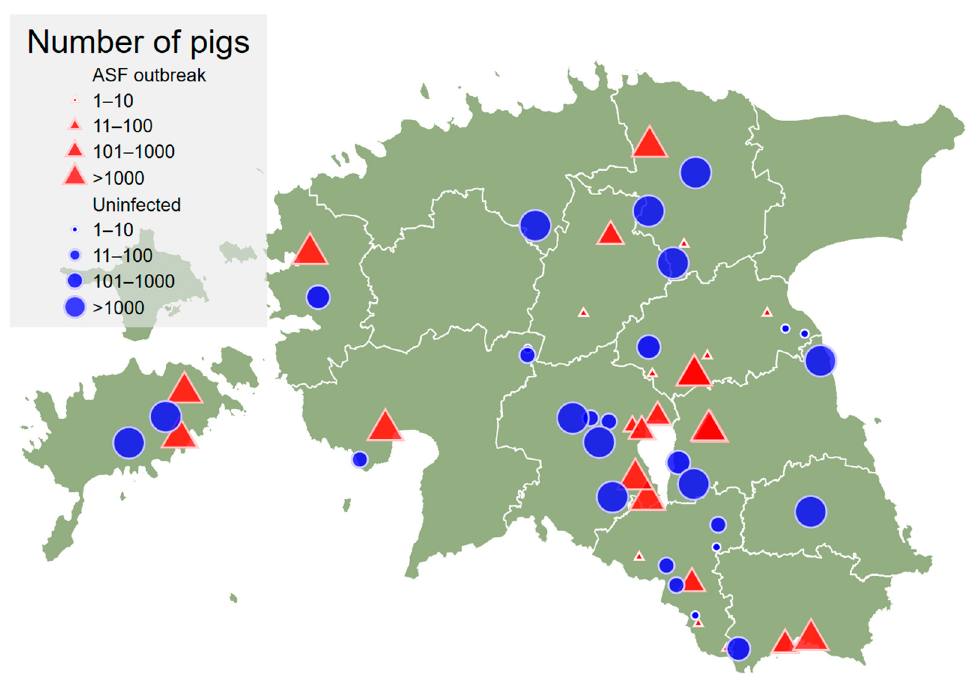
Figure 1. Location of the African swine fever outbreak herds (red triangles; n = 26) and uninfected herds (blue circles; n = 28) in Estonia . The size of the symbol indicates the size category of the herd based on total number of pigs in the herd.